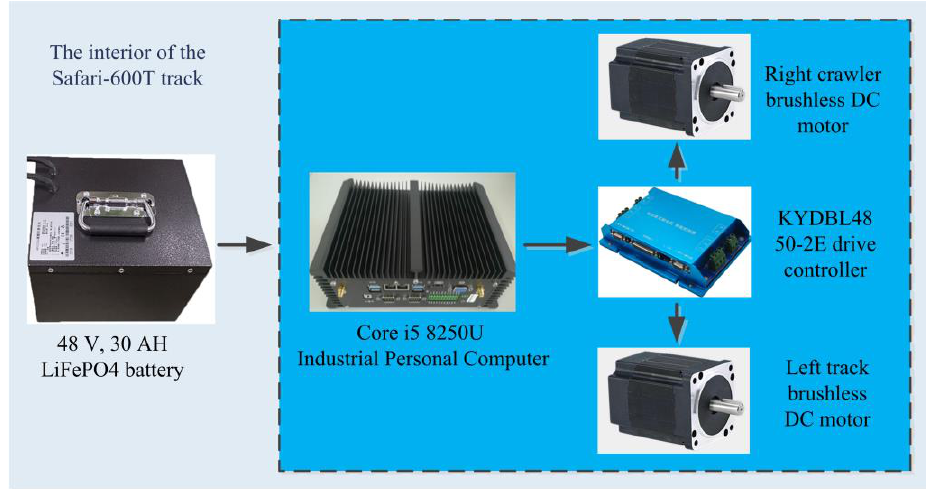
Figure 6. The main hardware of the motion unit.